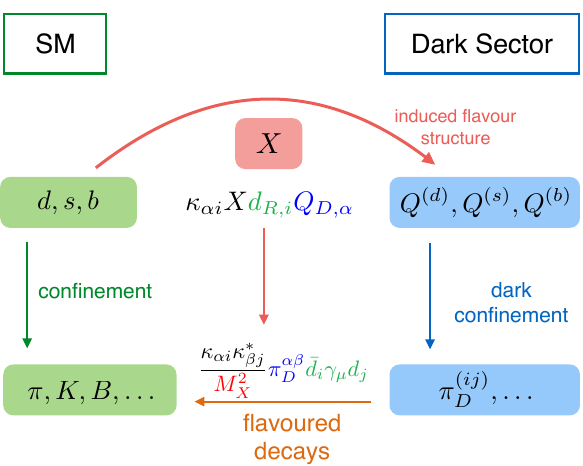
Figure 1. The composite dark sector communicates with the SM through a (cid:13)avoured dark portal: the mediator X is a bi-fundamental scalar coupling to quarks and dark quarks, thereby inducing a (cid:13)avour structure in the dark sector. The main consequence is that the dark pions, which are the lightest composite dark sector states, have lifetimes and branching ratios to SM particles which now depend on their (cid:13)avour